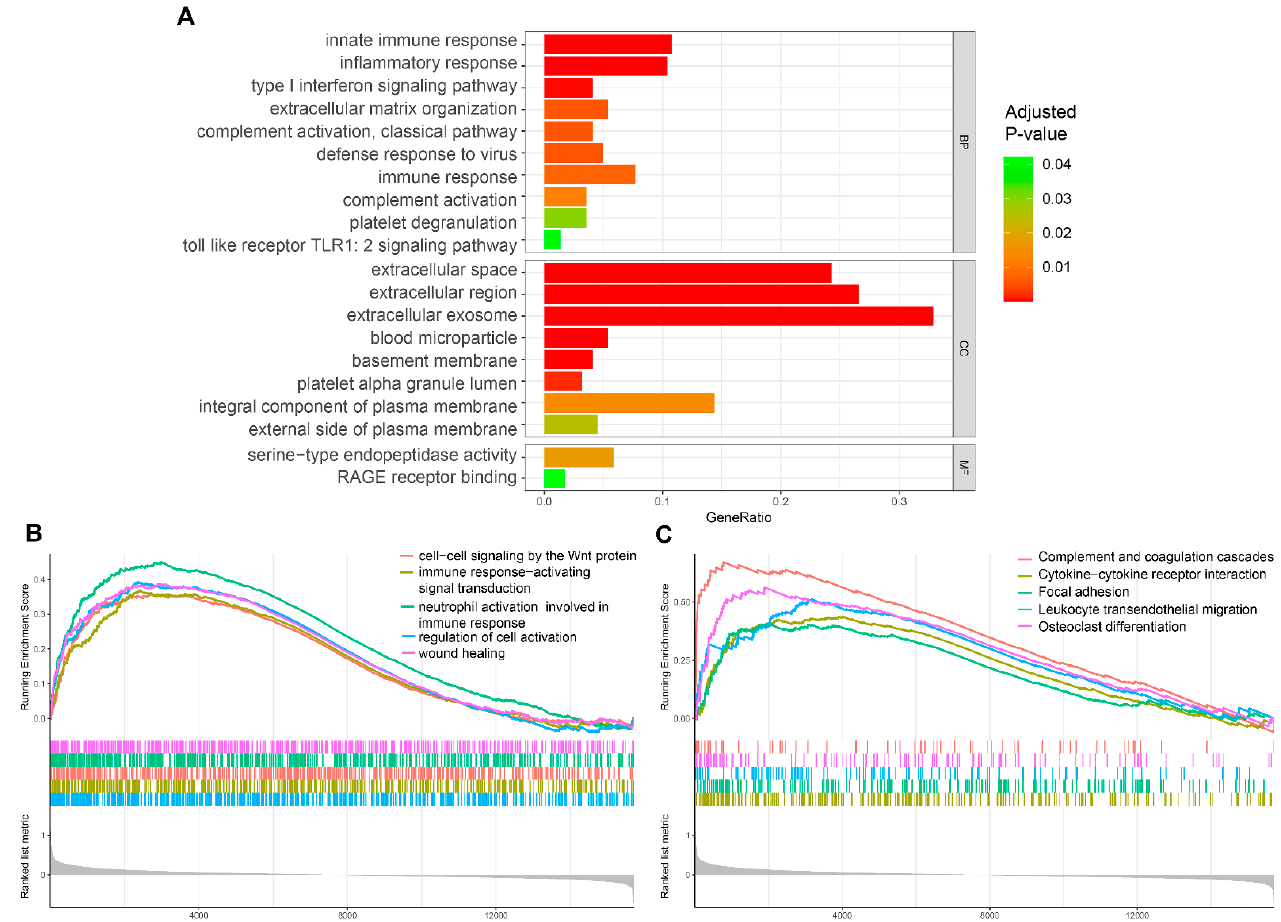
Figure 3. Functional enrichment analysis. ( A ) Biological processes, molecular functions, and cellular components enriched in AMD by gene ontology analysis. ( B ) Biological processes enriched in AMD by gene set enrichment analysis (GSEA). ( C ) KEGG pathways enriched in AMD by GSEA.